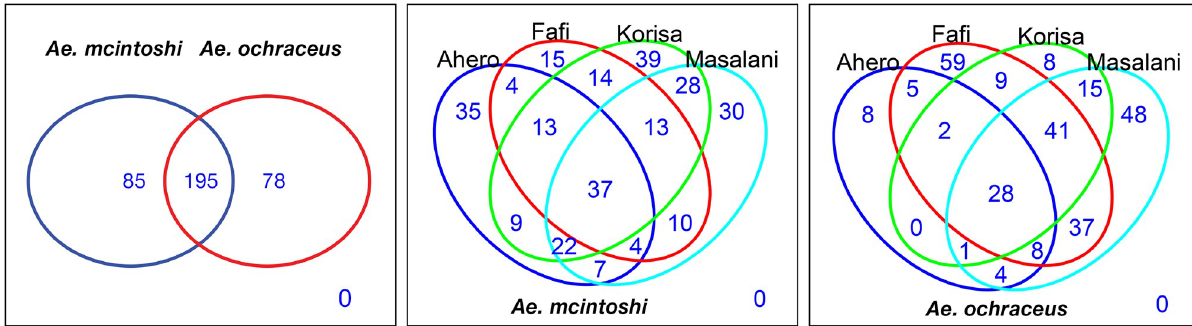
Fig 3. Number of shared and unique OTUs between Aedes mcintoshi and Aedes ochraceus and for each species between study